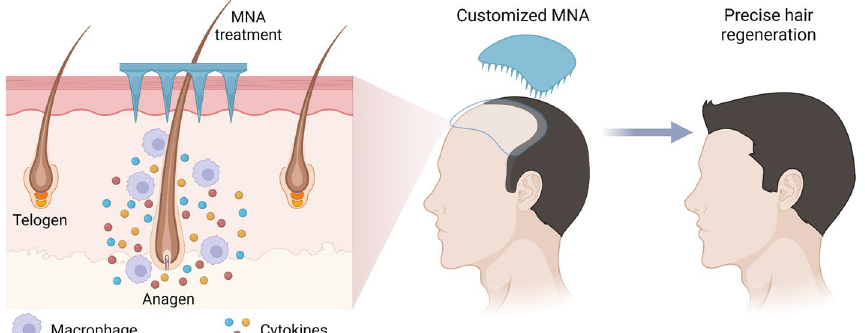
Fig. 9 Improving hair regeneration by customized microneedle arrays by recruiting macrophages in situ. The MNA treatment could induce hair regrowth in a defined area corresponding to the customized shape of the MNA. This result indicated that MNA treatment could recruit macrophages in situ and then initiate the proliferation of hair follicle stem cells, thereby improving hair regeneration. Moreover, the relative cytokines ( Hgf , Igf-1 , and Tnf-α ) were also upregulated in the treated skin. This method holds great potential for the personalized treatment of hair loss, which could lead to the development of future regenerative medicine. Created with